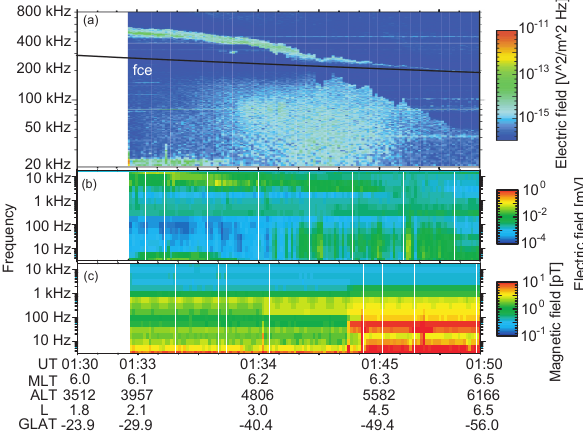
Fig. 2. An example of the electron flux enhancement in the inner belt during the period from 306 to 316 day of 1993 (a) . K p (b) and D st indices (c) . The pink and purple lines correspond to the dynamic spectra in Figs. 3 and 4, respectively.